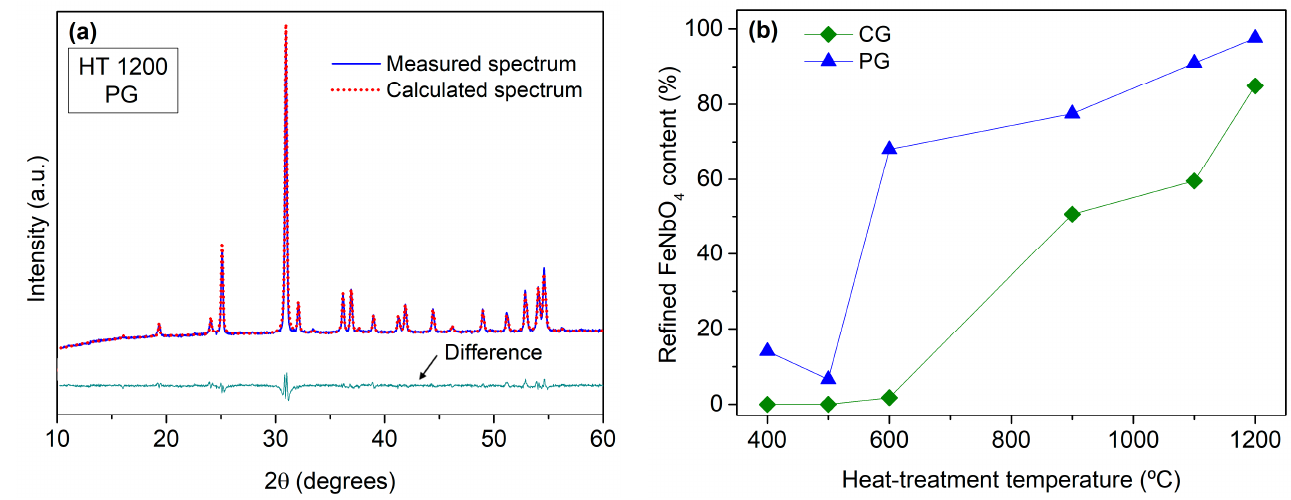
Figure 6. ( a ) Measured and calculated spectrum of the sample treated at 1200 °C and prepared via the polymeric gel method; ( b ) variation percentage of the FeNbO 4 content as a function of the heat ‐ treatment temperature, as estimated via the Rietveld analysis.